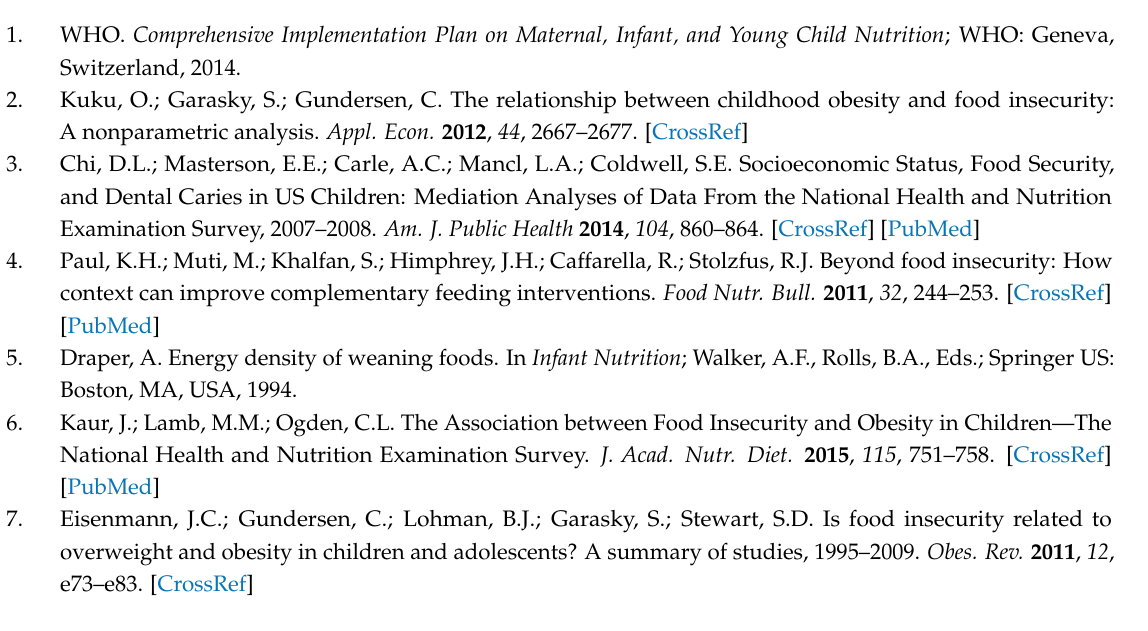
Figure S1: Consort Diagram, Figure S2: Histogram of Infant Food Security, Figure S3: Normal Q-Q Plot of Infant Food Security